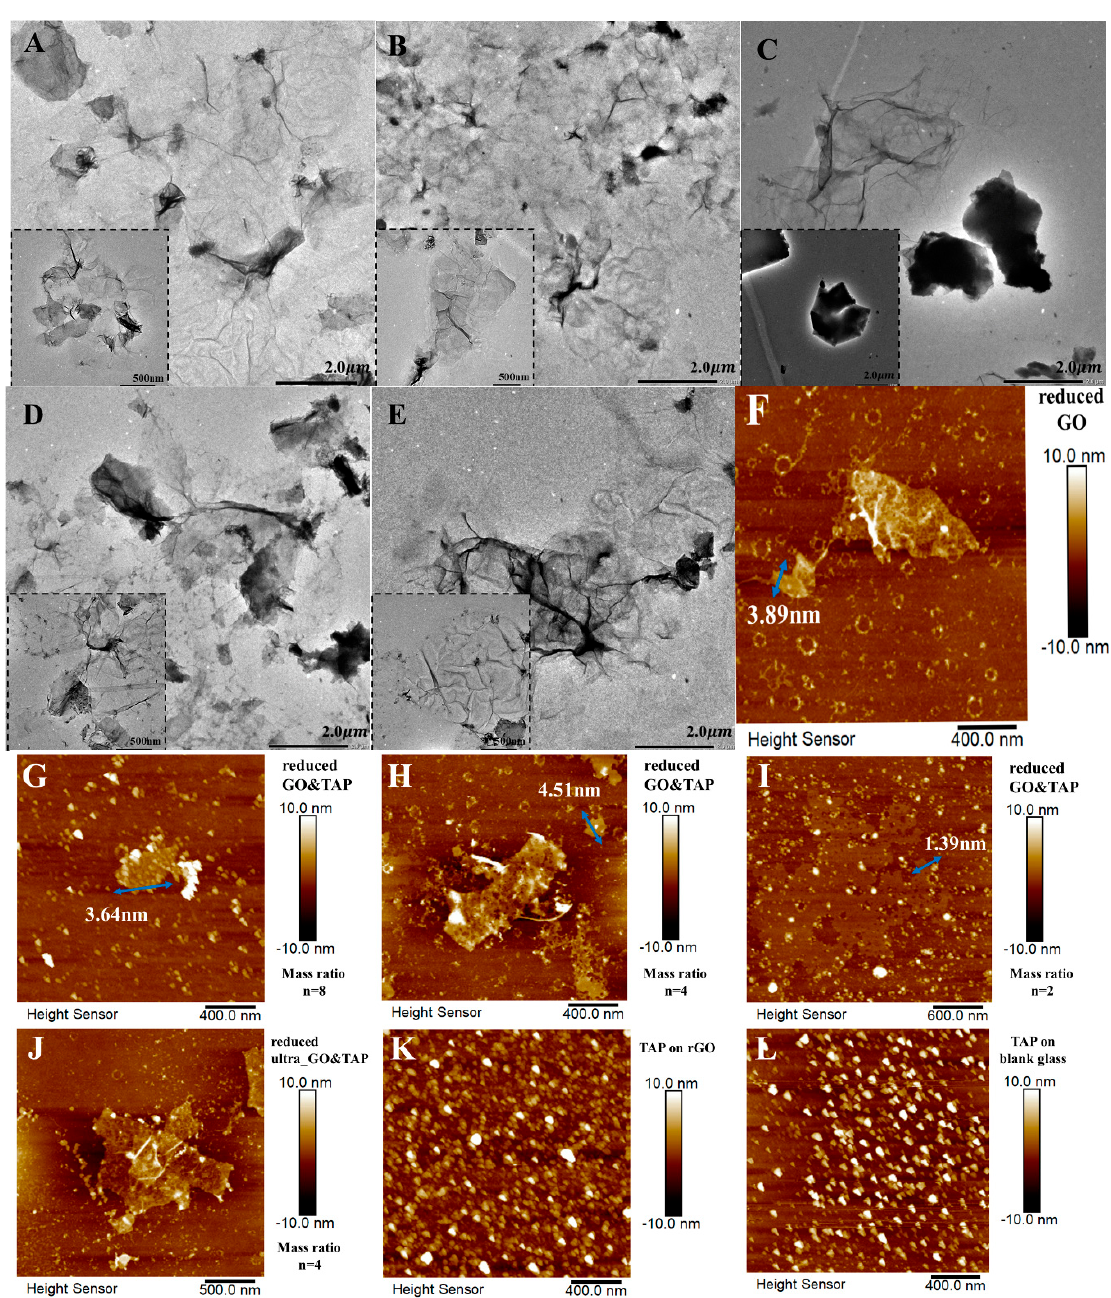
Figure 4. TEM photos of reduced GO&TAP ( A ) and reduced ultra_GO&TAP ( B ), with the same mass ratio of GO:TAP = 4, in comparison with rGO with drop-coated TAP ( C ), together with the photos of reduced GO&TAP with a mass ratio of GO:TAP = 8 ( D ), and 2 ( E ). The thickness of the rGO nanolayers in rGO ( F ) and reduced GO&TAP with different mass ratio of GO:TAP, n = 8 ( G ), 4 ( H ), and 2 ( I ) are estimated by using their atomic force microscope (AFM) and the software of NanoScope Analysis 1.5. For comparison, AFM images of reduced ultra_GO&TAP with the mass ratio of GO:TAP = 4 ( J ), drop-coated TAP layer on the rGO-coated ( K ) and the blank glass slides ( L ) are given.